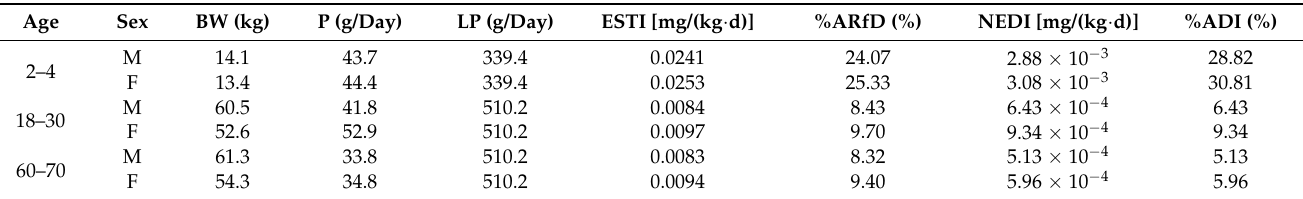
Table 1. Dietary intake assessment of prochloraz in bananas under field